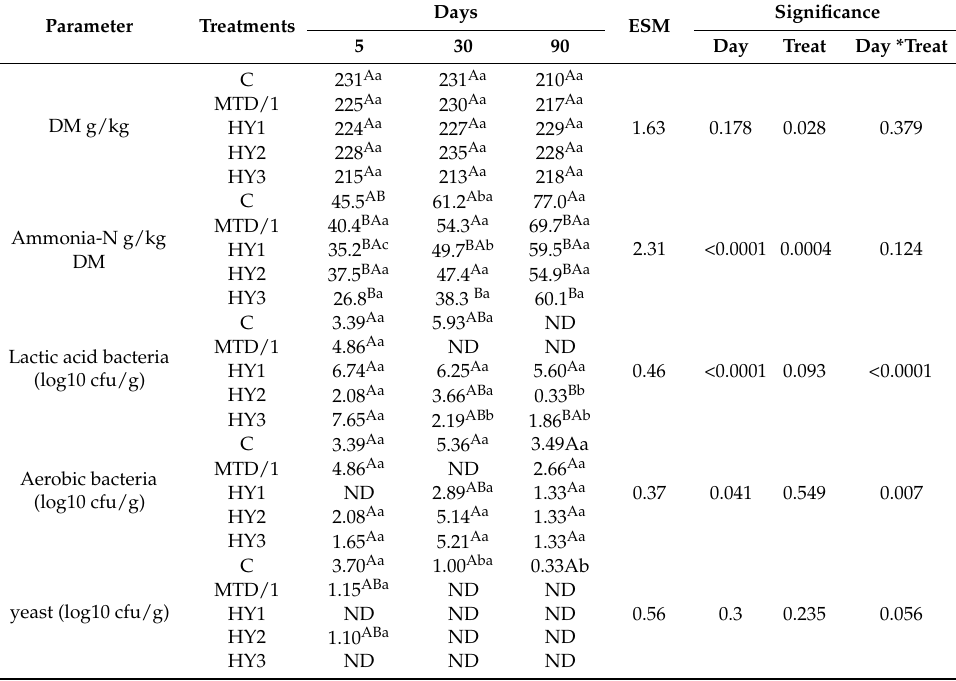
Table 3. Effects of LAB inoculant on DM, Ammonia-N and microbial counting of sweet sorghum ensiling for 90 days.